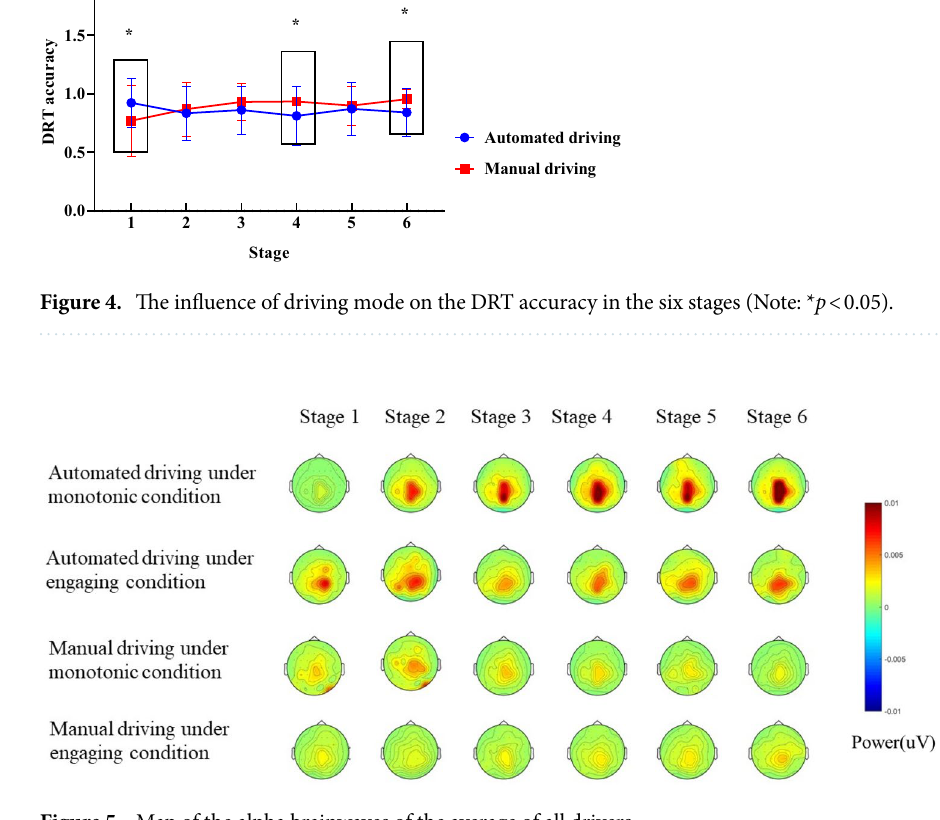
Figure 5. Map of the alpha brainwaves of the average of all